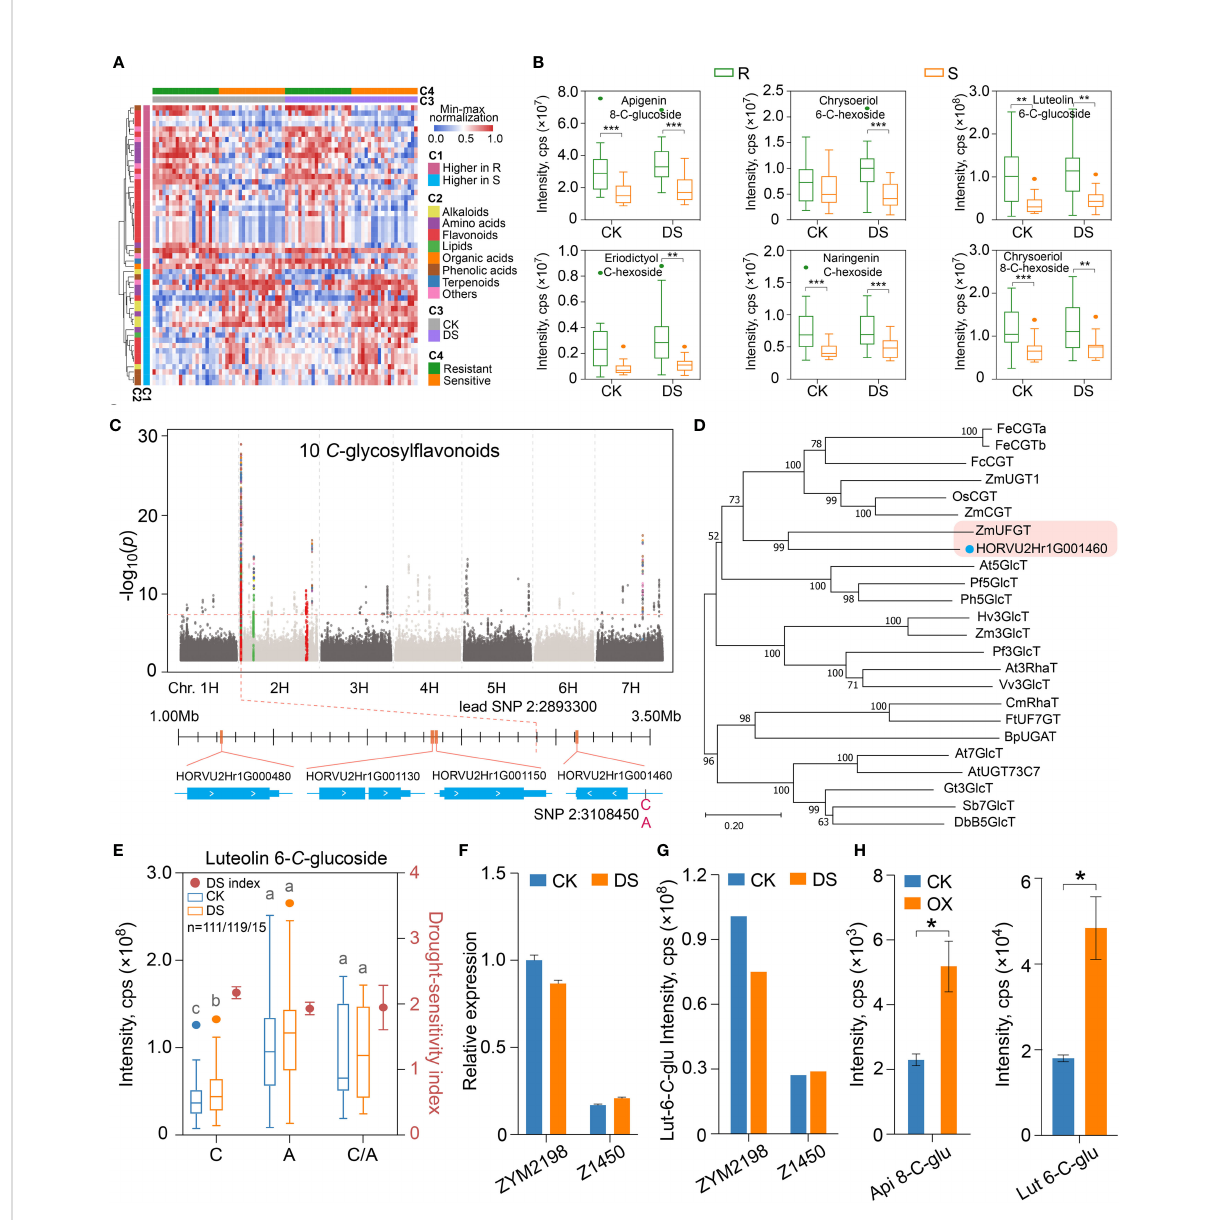
FIGURE 6 The synthesis of constitutive C -glycosyl fl avonoids that contribute to drought resistance is regulated by a C -glucosyl transferase gene in qingke. (A) The heatmap showing the metabolites accumulated differentially in drought-resistant and drought-sensitive qingke after drought stress, and the accumulation of these metabolites before and after drought stress. C1: differential patterns of metabolites; C2: classi fi cation of metabolites; C3: control (CK) or under drought stress (DS); C4: grouping of drought-resistant (R) and drought-sensitive (S) qingke. (B) The boxplot represents the C -glycosyl fl avonoids with enhanced accumulation in drought-resistant qingke (R, green) than that in drought-sensitive qingke (S, orange) under CK and CS condition. (C) Manhattan plot displaying the mGWAS co-location of 10 C -glycosyl fl avonoids in CK condition. Colored dots indicate SNPs in signi fi cance association loci. Four gene models representing CYP450 (HORVU2Hr1G000480, HORVU2Hr1G001130, HORVU2Hr1G001150) and glycosyl transferase (HORVU2Hr1G001460) found in the signi fi cance association loci are shown. (D) An unrooted phylogenetic tree of glycosyl transferase was constructed as described in Methods. Bootstrap values (based on 1000 replications) are indicated at each node (bar: 0.2 amino acid substitutions per site). (E) Luteolin-6- C -glucoside content (boxplot, corresponding to the left y axis) and drought-sensitivity index (dot plot, corresponding to the right y axis) of qingke corresponding to the SNP 2H:3108450 under CK (blue) and DS (orange) condition, C, A and C/A represent reference, alternate and heterozygous base, different letters on boxplot indicate signi fi cant differences according to Students ’ t test at P -value<0.05. (F) Relative expression of HORVU2Hr1G001460 gene in drought-resistant qingke (ZYM2198) and drought-sensitive qingke (Z1450) under CK and DS conditions. Data are shown as the mean ± SEM, n = 3. (G) The contents of luteolin-6- C - glucoside in ZYM2198 and Z1450 under CK and DS conditions, respectively. (H) Accumulation of apigenin-8- C -glucoside (api 8- C -glu) and luteolin-6- C - glucoside (lut 6- C -glu) in tobacco leaves that transiently overexpress HORVU2Hr1G001460. The asterisk represents a signi fi cant difference of Students ’ t test at P -value <0.05 between CK and overexpression line (OX). Data are shown as the mean ± SEM, n = 3. Student ’ s t-test, P-value < 0.05, marked with “ * ” P- value < 0.01, marked with “ ** ” P-value < 0.001, marked with “ *** ”